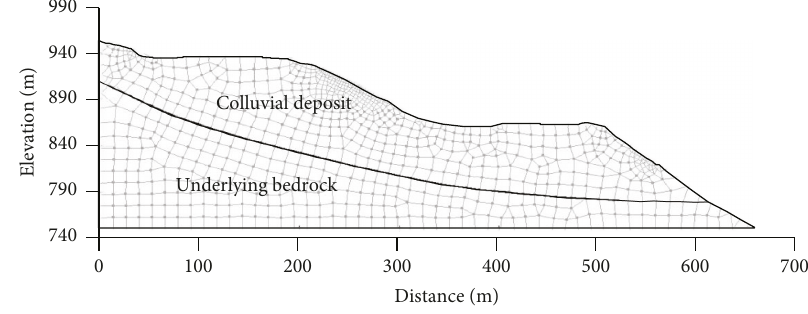
Figure 15: The established model of Hongyanzi landslide (unit: m). Table 2: Physical parameters used in numerical